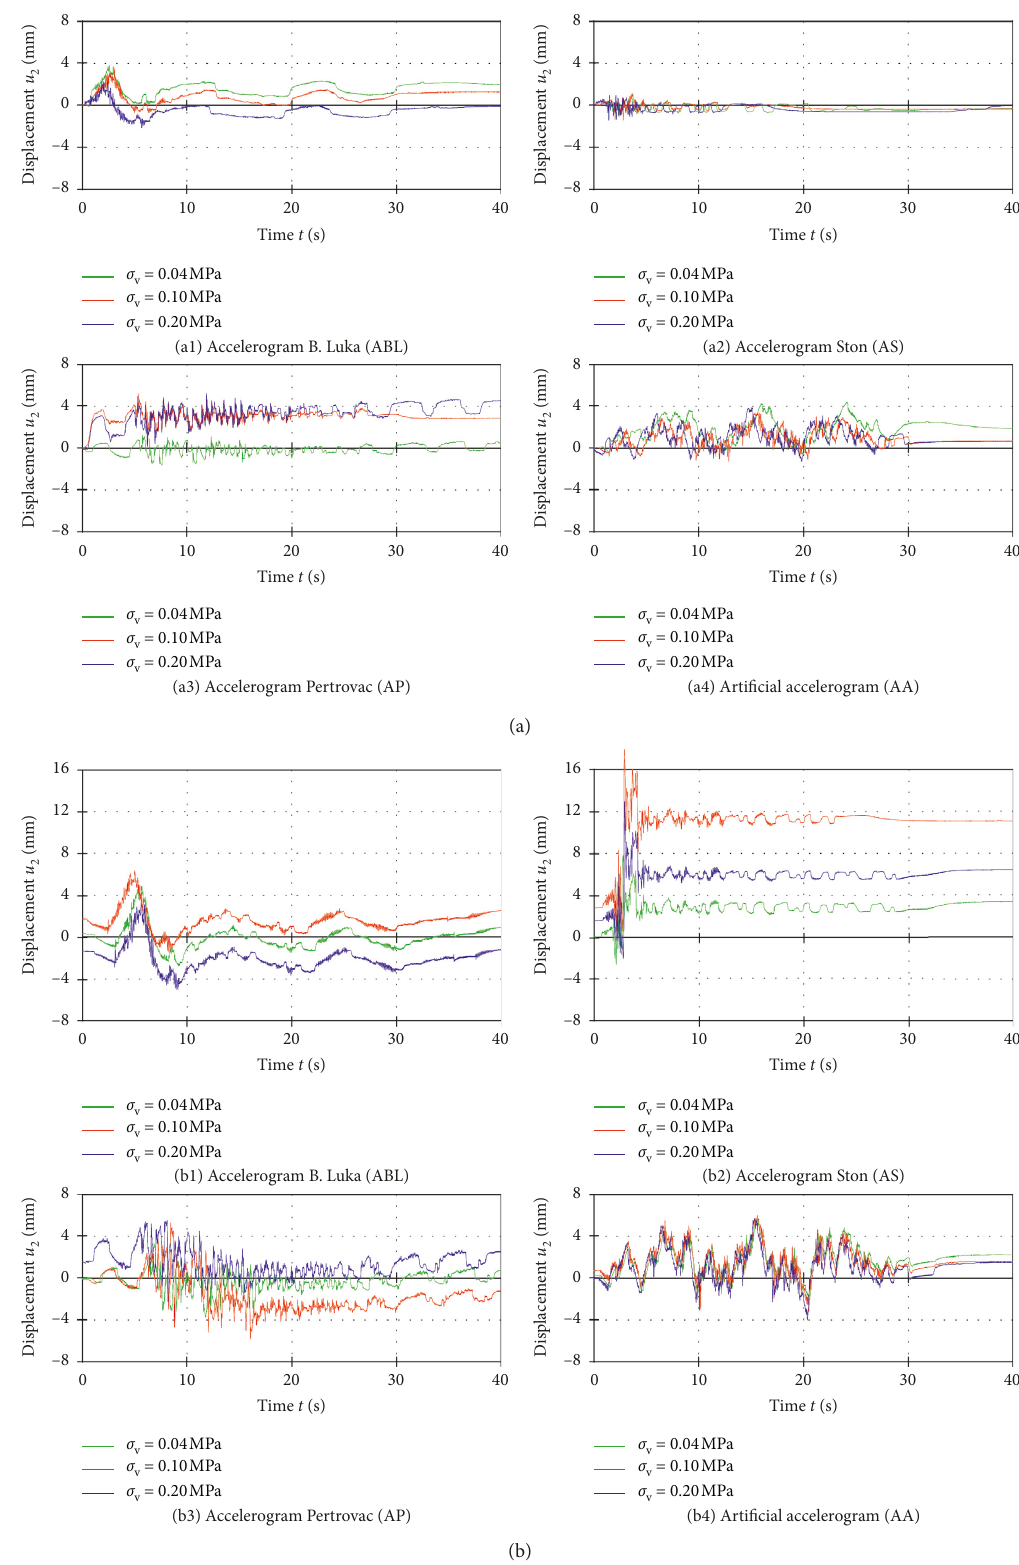
Figure 24: The effect of vertical contact stress below the foundation on horizontal displacement u